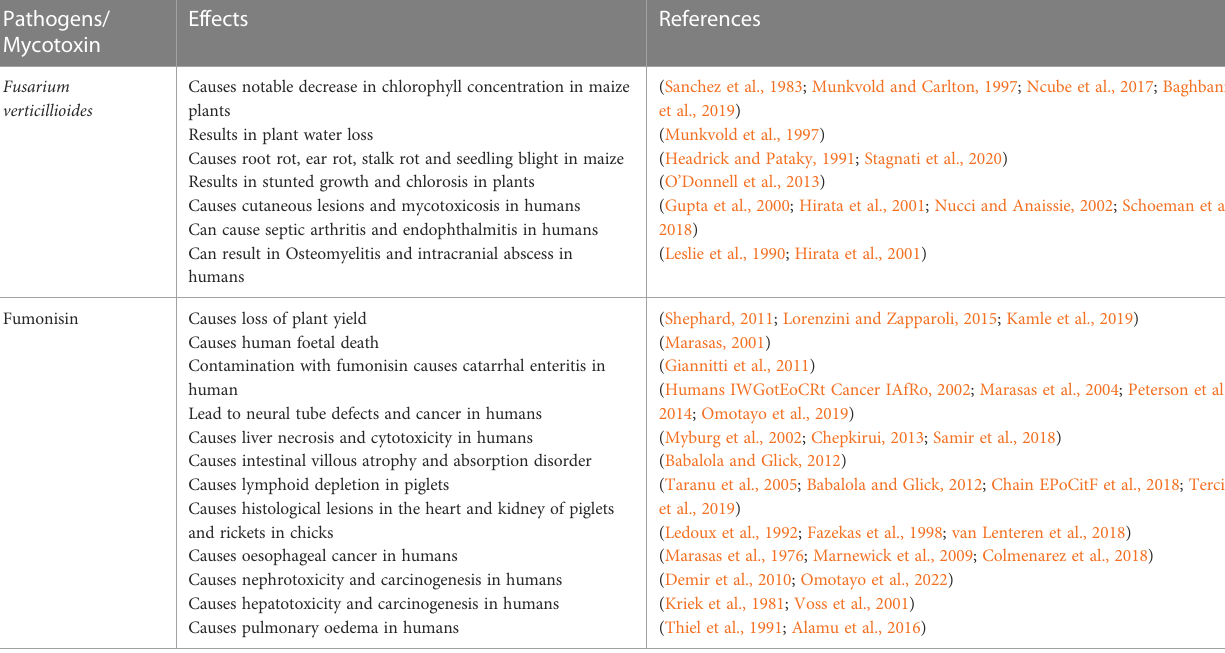
TABLE 1 Other effects of F. verticillioides and Fumonisin on the plant, animal, and human health. Pathogens/